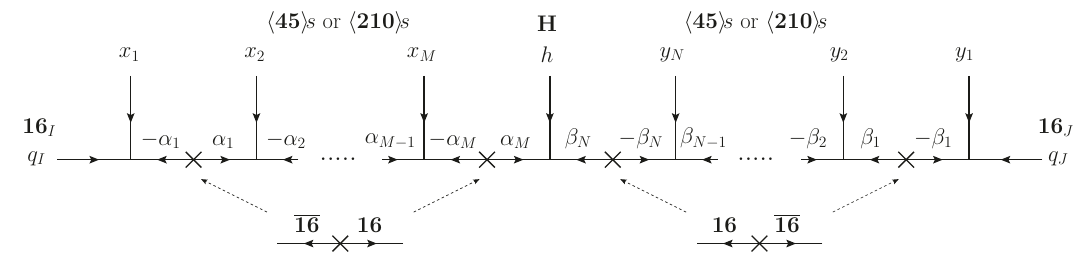
label the charges I ( J )